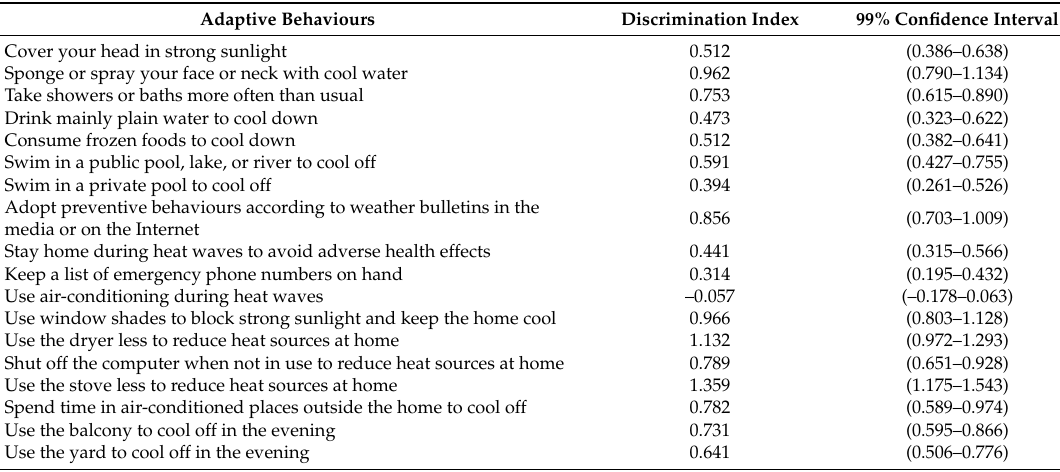
Table 1. Discrimination indices for each adaptive